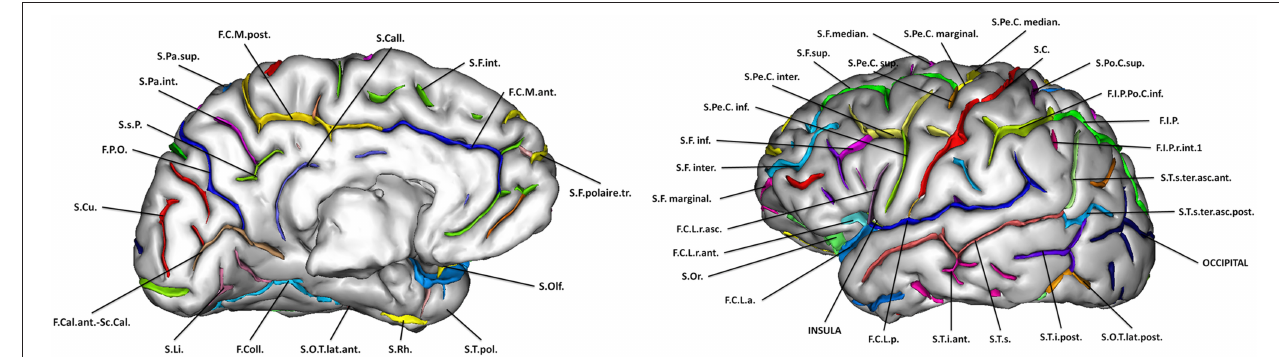
FIGURE 3 | Sulci segmented via the Morphologist toolbox of the Brainvisa software.